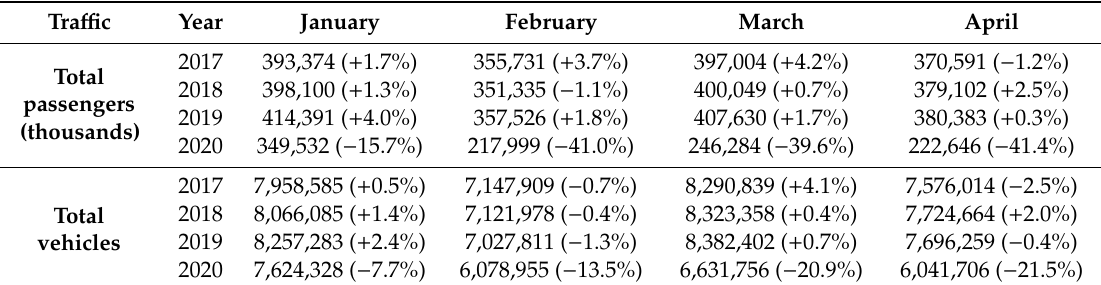
Table 4. Monthly traffic data of total passengers taking the public transport and total vehicles through